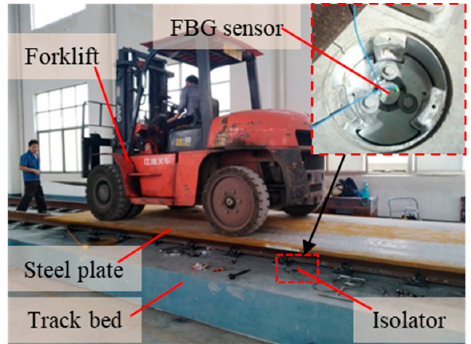
Figure 13. Random dynamic load test of sensor.